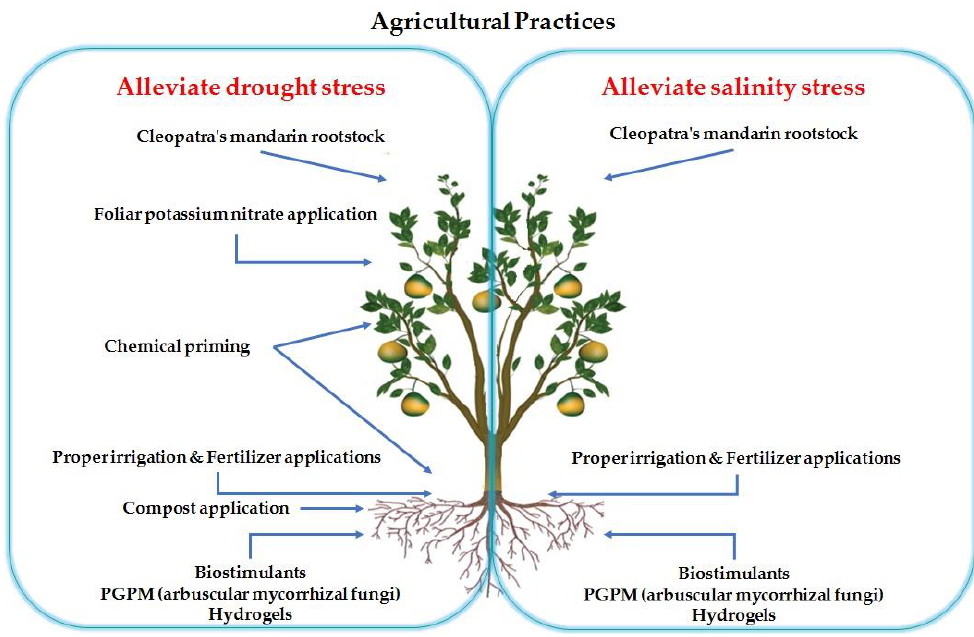
Figure 1. A mechanism diagram of agricultural measures to alleviate citrus drought and salinity.